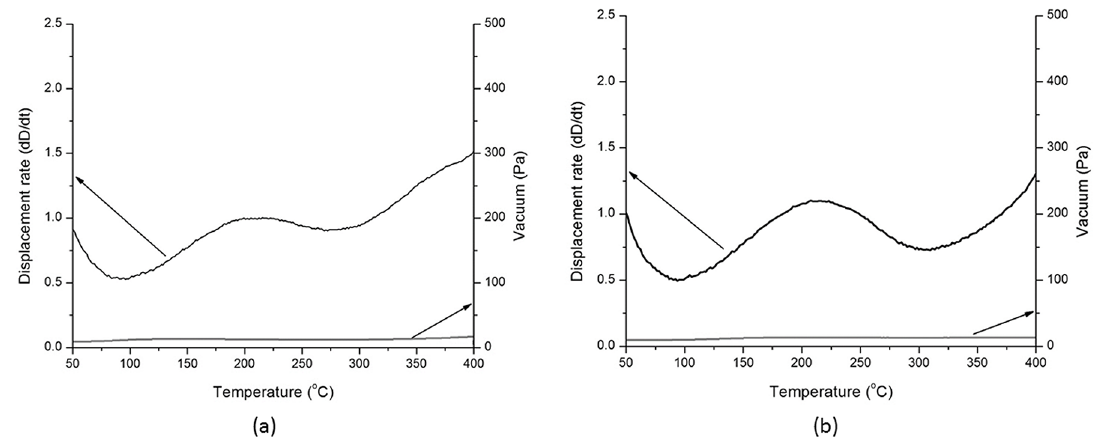
Figure 6. Sintering curves of the samples milled for 8 h and degassed for 20 h at (a) 250 °C and (b) 350 °C at 60 MPa of pressure.